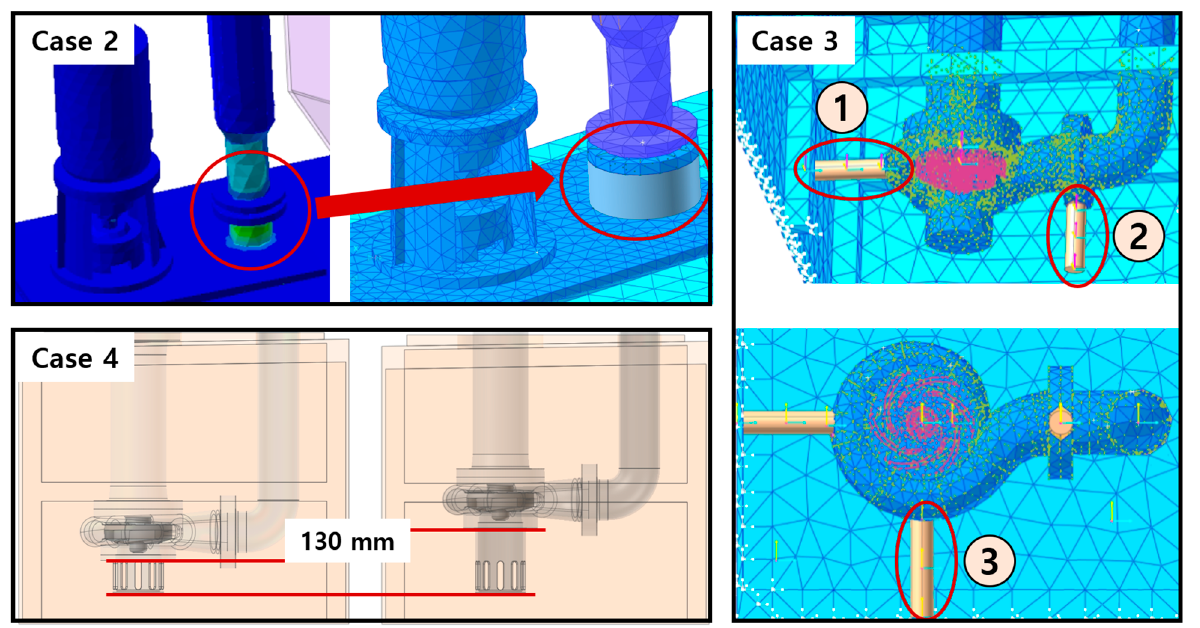
Figure 7. Image showing the design variables (case 2–4).